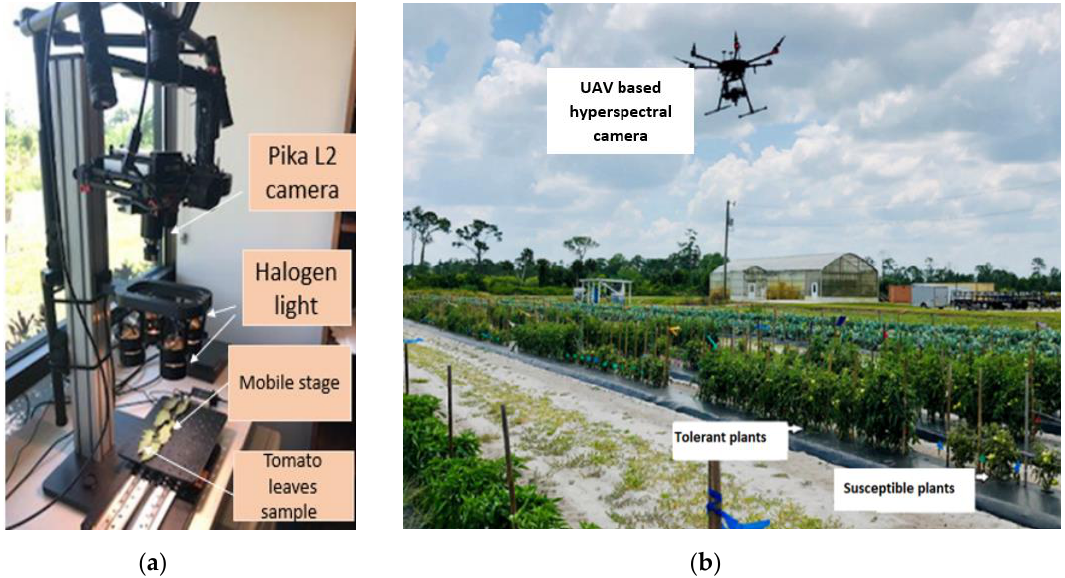
Figure 2. ( a ) Benchtop Pika L 2.4 camera with leaf samples in the laboratory condition. ( b ) Unmanned aerial vehicle (UAV) using hyperspectral sensing to collect spectral reflectance data from susceptible and tolerant tomato plants infected with tomato yellow leaf curl. The data were collected after 50–60 days from transplanting on 30 April 2019.